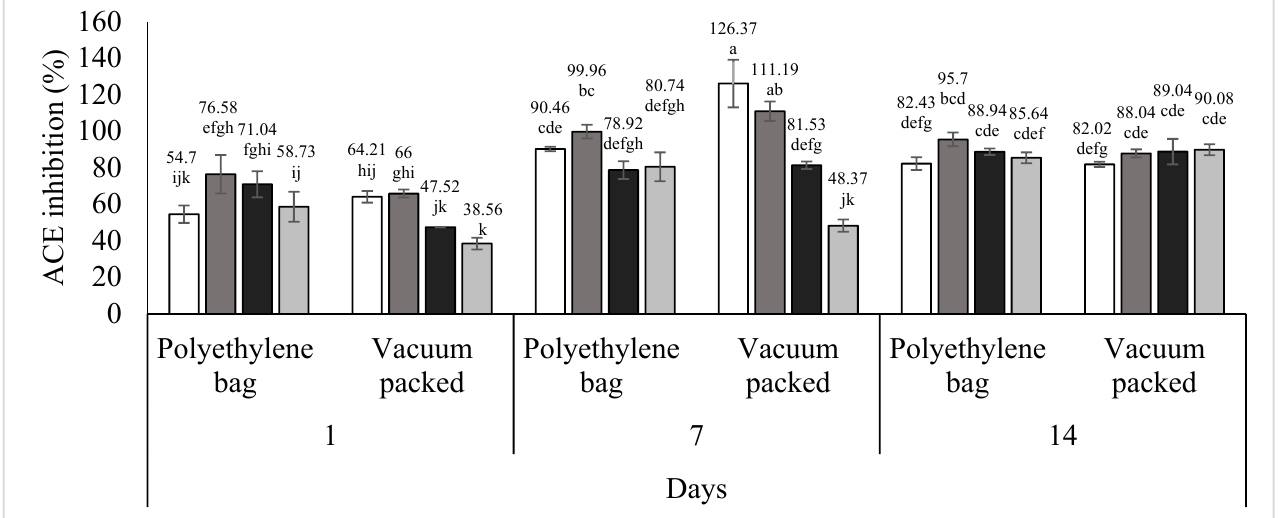
Figure 5. ACE-inhibition of requeson cheese with different salt type and concentration treatments, conventional and vacuum packaging. a–k Values with a different superscript indicate significant statistical difference ( p < 0.05).